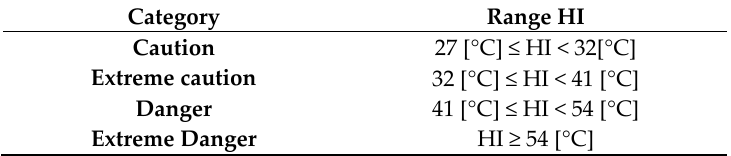
Table 1. Range of values reached by Heat Index and related levels of